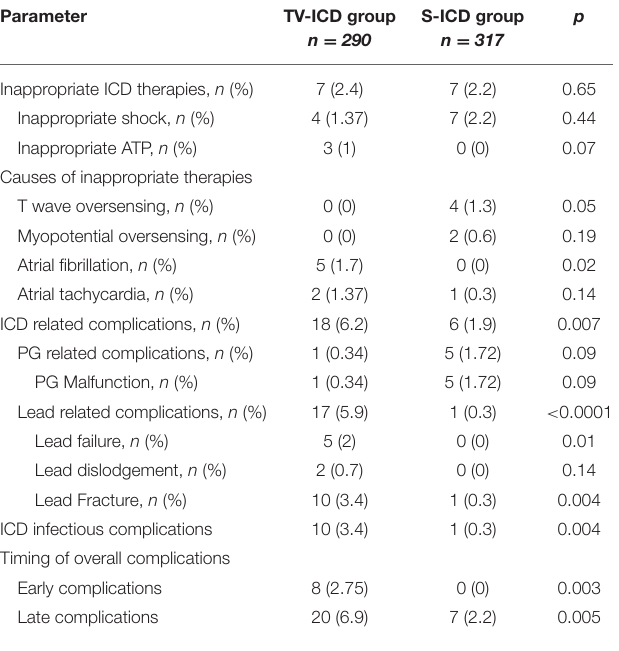
TABLE 3 | Primary outcome events at follow-up. TABLE 4 | Number of patients with at least one appropriate ICD therapy across different patients